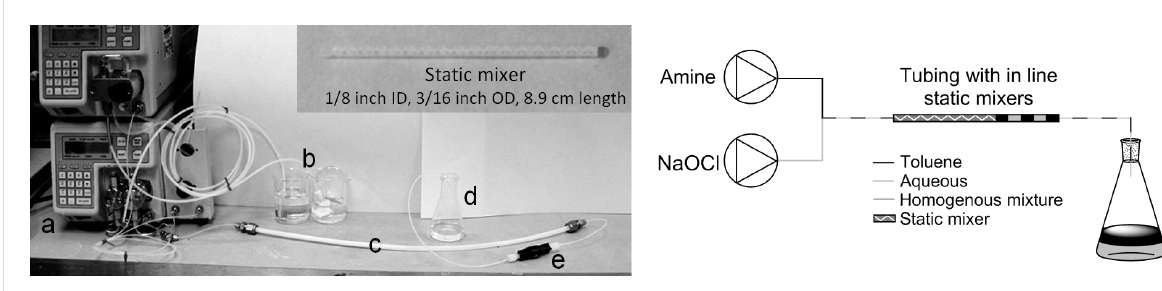
Figure 2: Meso-scale static mixer set-up for continuous N -chloramine formation. (a) Pumps, (b) reagent solution reservoirs, (c) reactor tube containing static mixers, (d) collection vessel, (e) back pressure regulator (75 psi).